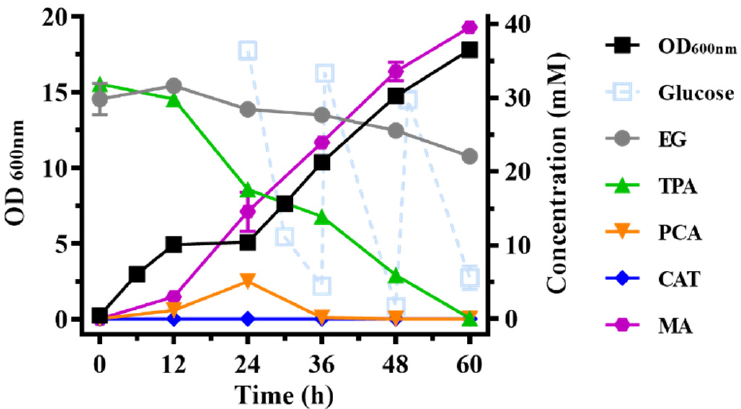
Figure 4. Bioconversion of the PET hydrolysate to produce MA by P. putida KT2440-tacRDL. TPA, terephthalate; PCA, protocatechuate; CAT, catechol; MA, muconic acid; EG, ethylene glycol. The experiments were performed in duplicate.